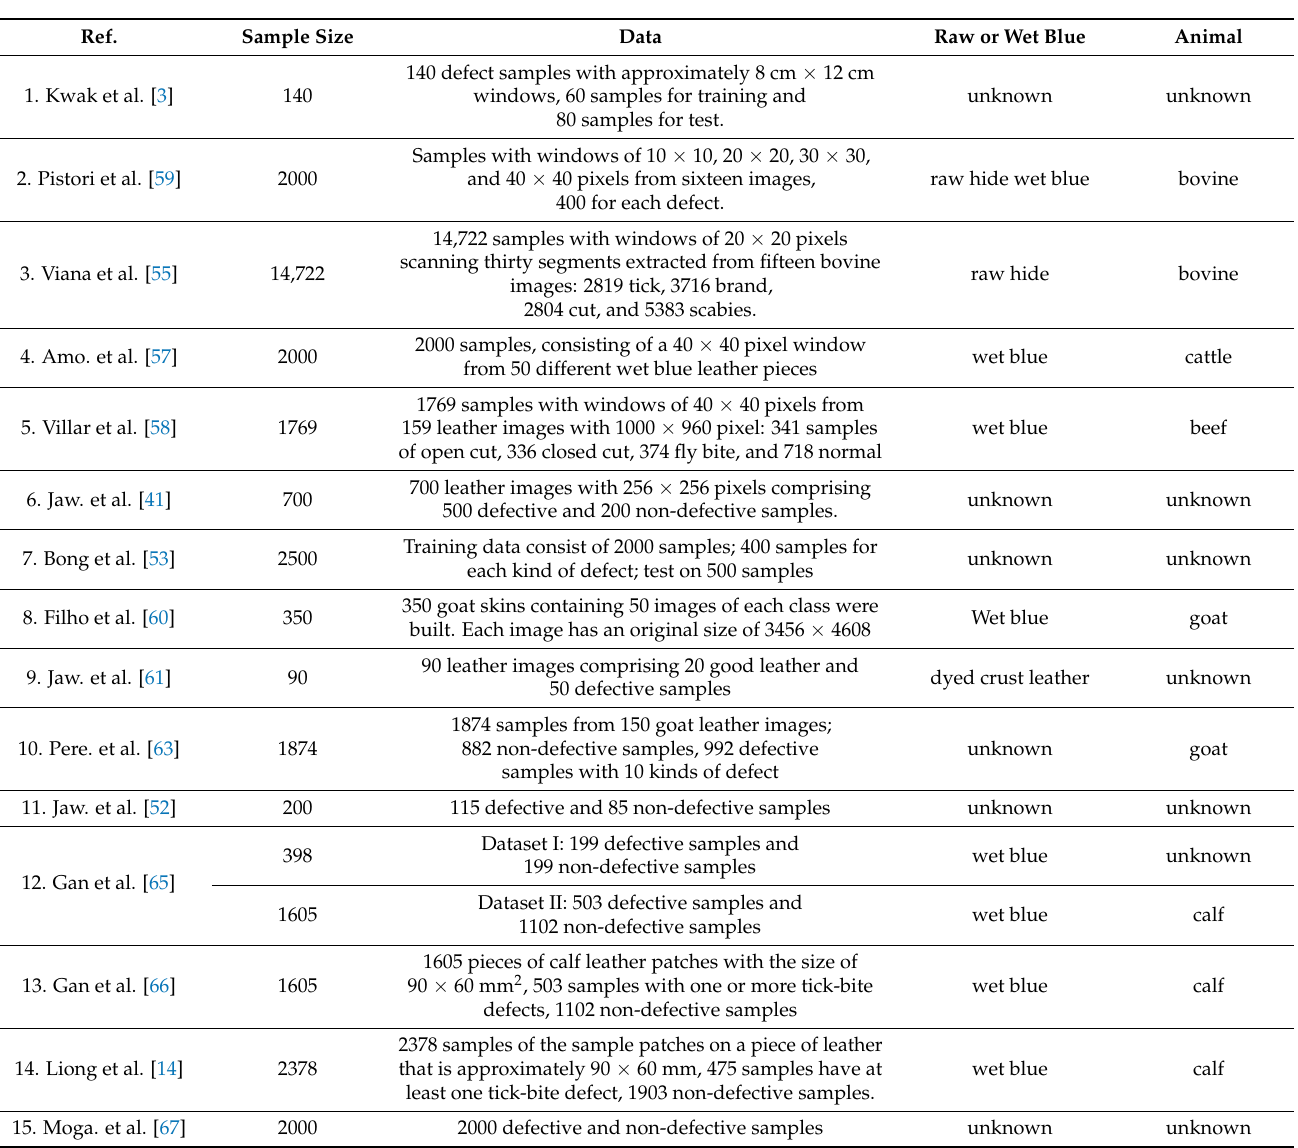
Table 5. Dataset used in the literature.